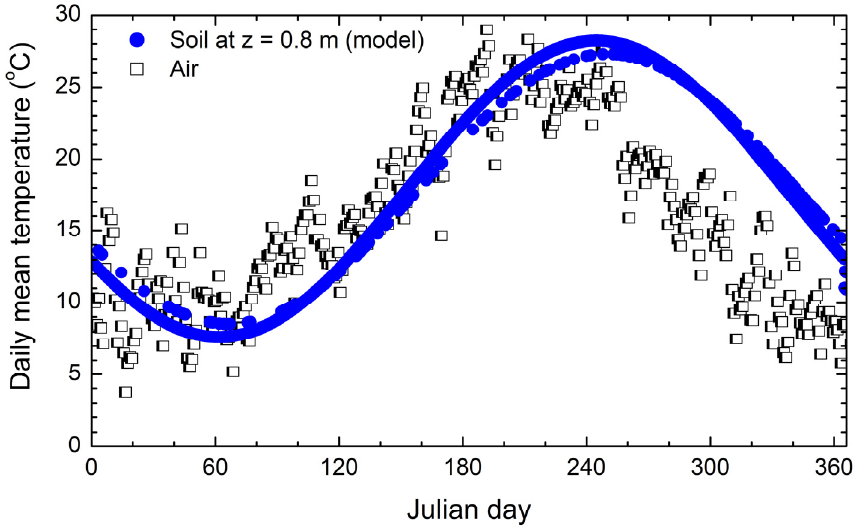
Figure 11. Temperatures of daily mean air (observed) and soil ( z = 0.8 m, calculated for both dry and saturated, when rain recorded, conditions). Year 2016. Data available in the Supplementary Materials.